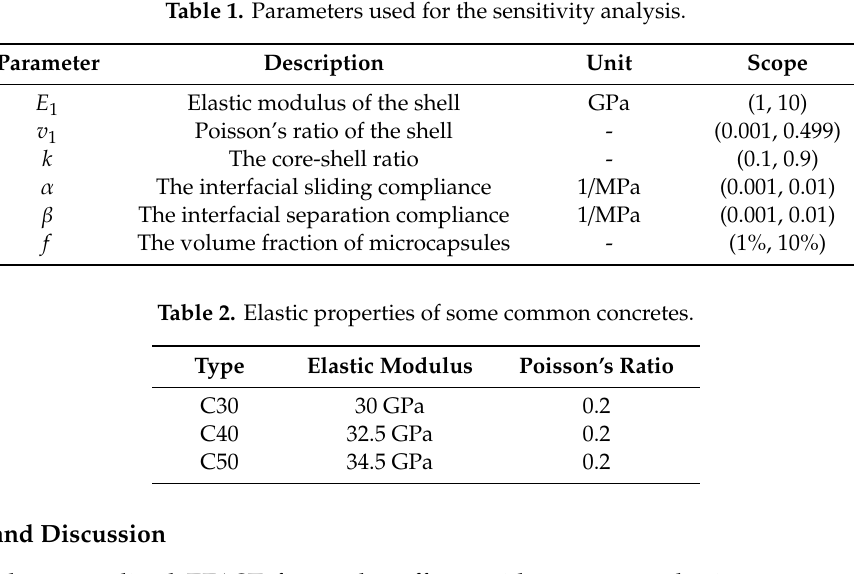
Table 1. Parameters used for the sensitivity analysis.